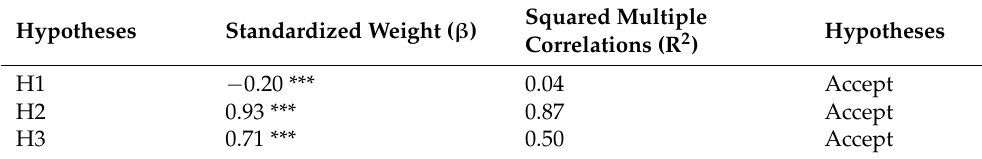
Table A4. Test of